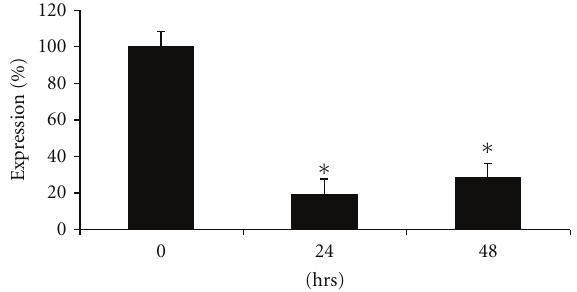
Figure 6: Downregulation of steady-state level of c- Myc mRNA by AIC. See text for details. Data are mean + S.D. of 3 independent experiments. ∗ P < . 01 compared with control